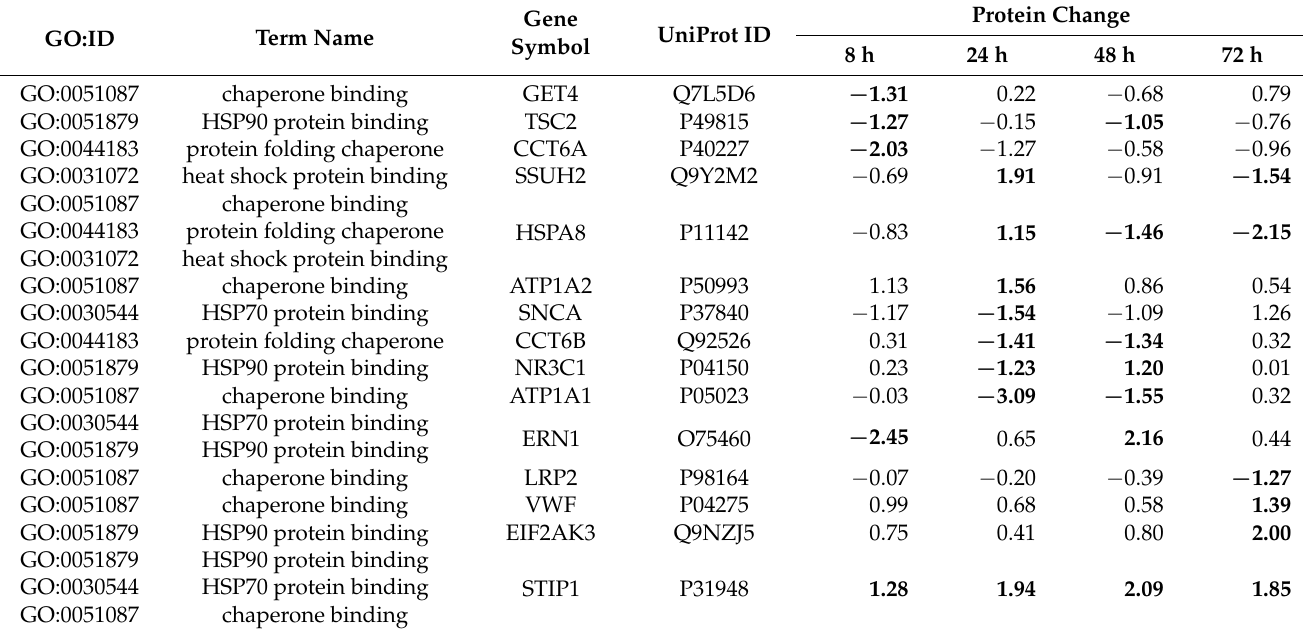
Table 3. Gene ontology of DEPs associated with chaperone